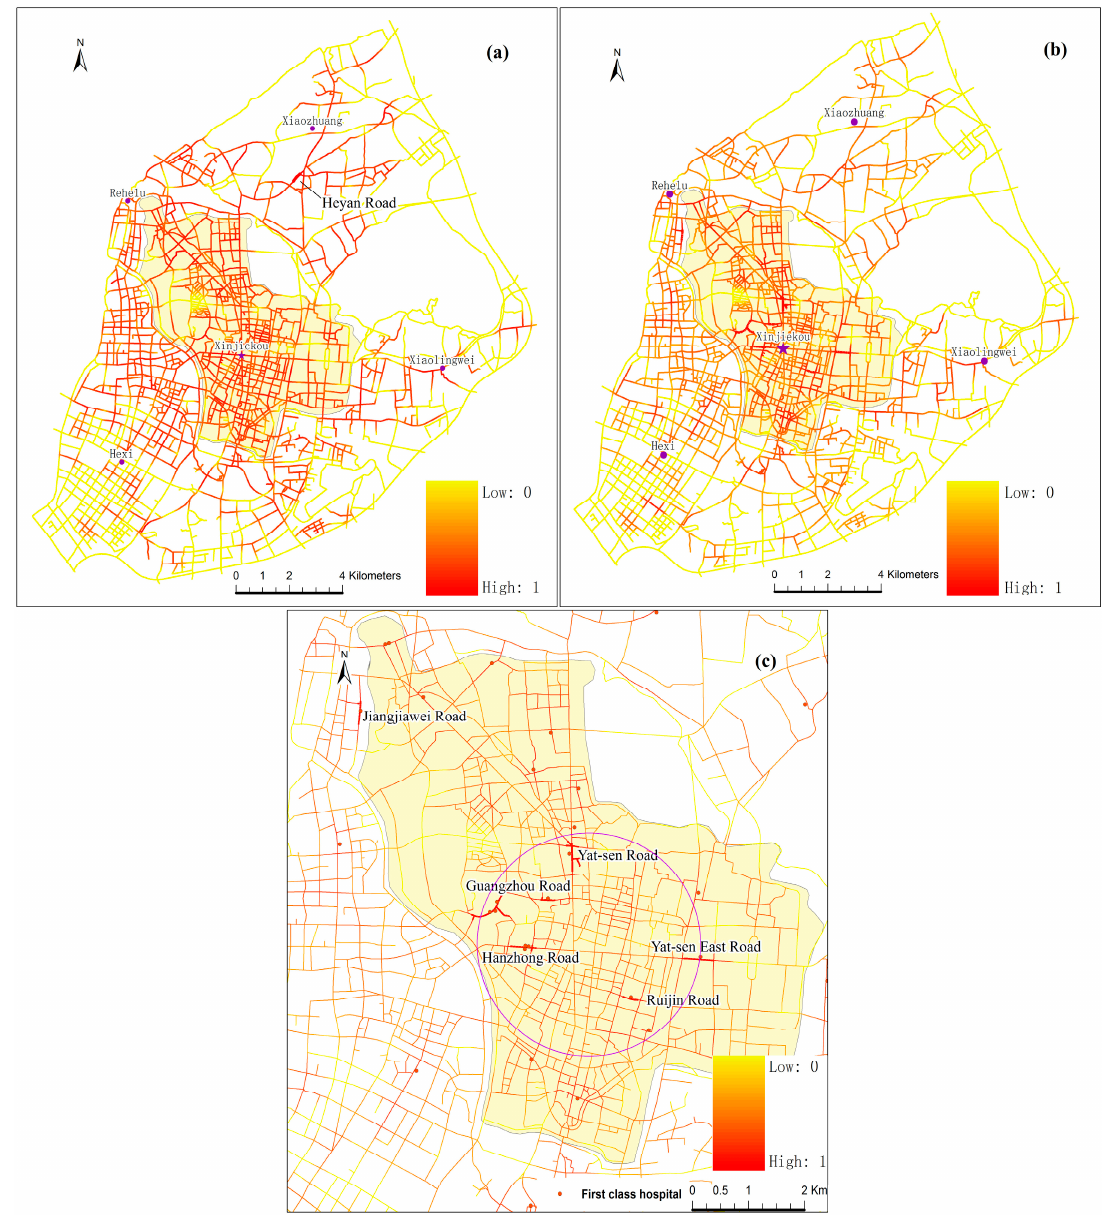
Figure 3. ( a ) Unweighted NetKDE results; ( b ) weighted NetKDE results; and ( c ) weighted NetKDE results around the city center for hospitals.